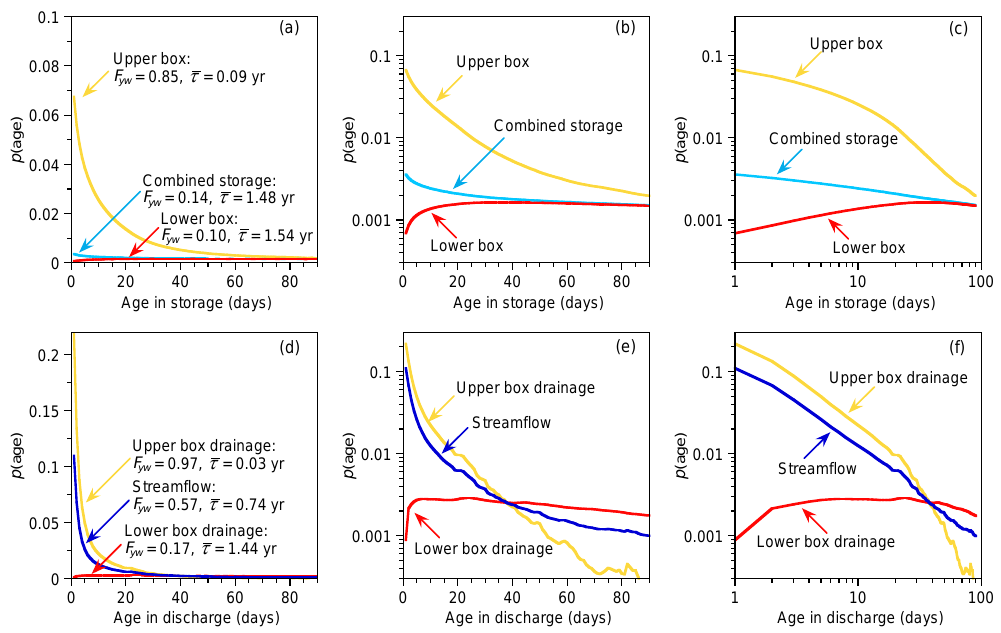
Figure 5. Marginal (time-averaged) age distributions in storage (a–c) and drainage (d–f) in the reference case simulation (Fig. 3), shown on linear (a, d) , log-linear (b, e) , and double-log (c, f) axes. Distributions in drainage (lower panels) are skewed toward younger ages than the storage distributions that they come from (upper panels). This arises, even though drainage is not age-selective, because storage is flushed more quickly (and thus is younger) during periods of higher discharge. Age distributions in the upper box, combined storage, and streamflow are more skewed than exponentials (i.e., they are upward-curving in the middle panels). The age distributions in the combined storage and streamflow (blue lines) are approximate power laws; i.e., they are nearly straight in the right-hand panels, with markedly different power-law slopes. The light blue line in the upper panels shows the age distribution of the combined upper and lower boxes, which resembles the age distribution of the lower box because the reference parameter values imply that the lower box comprises about 95% of total storage. However, direct drainage from the upper box comprises 50% of streamflow; thus, the streamflow age distribution (shown by the dark blue line in lower panels) reflects the strong skew of the upper box age distribution. Although both boxes are well mixed and have nearly constant volumes, the age distribution of discharge clearly differs from the distribution that would be expected in steady state, which would be exponential in the short-time